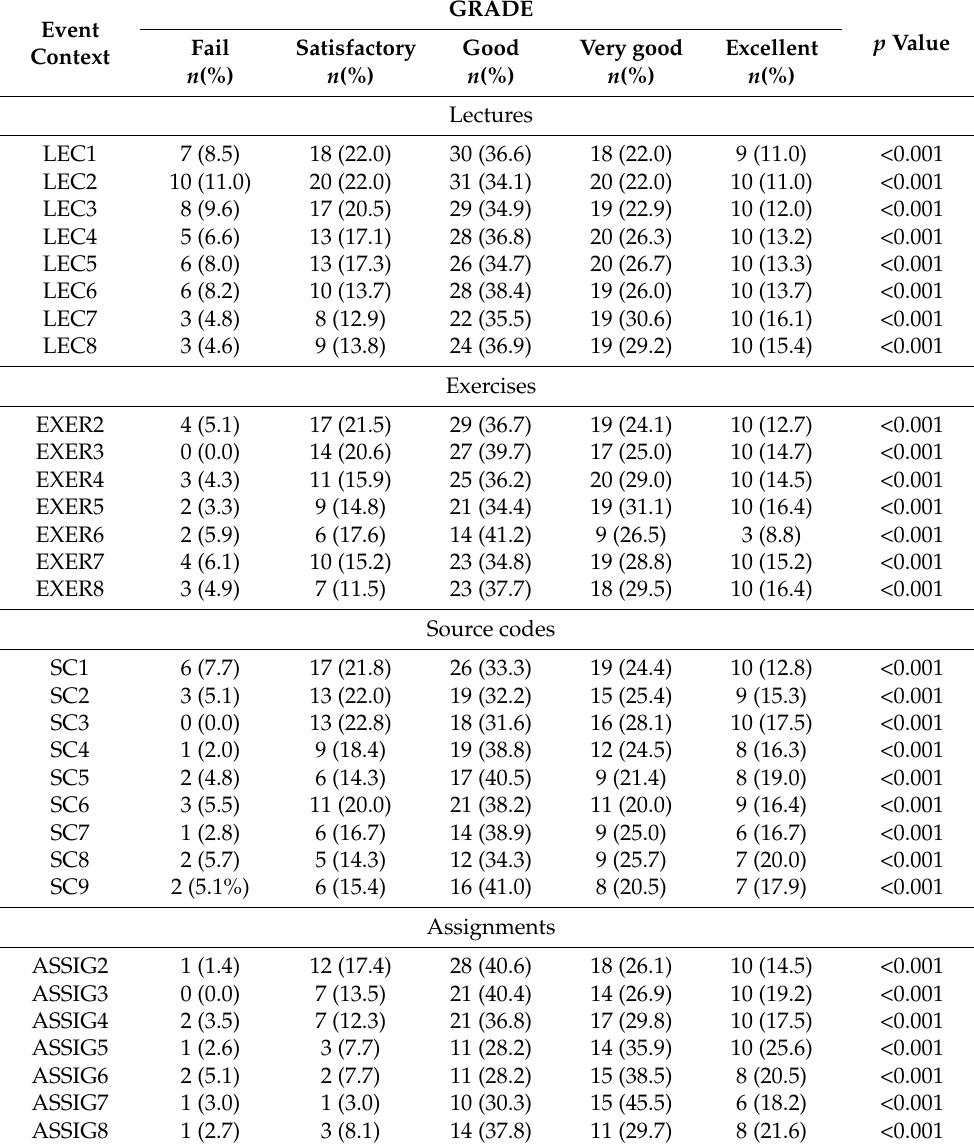
Table 2. Assessing the association between learning content (lectures, exercises, and source codes), one type of activity (assignment), and academic performance (Grade) with p -values obtained from a chi-square